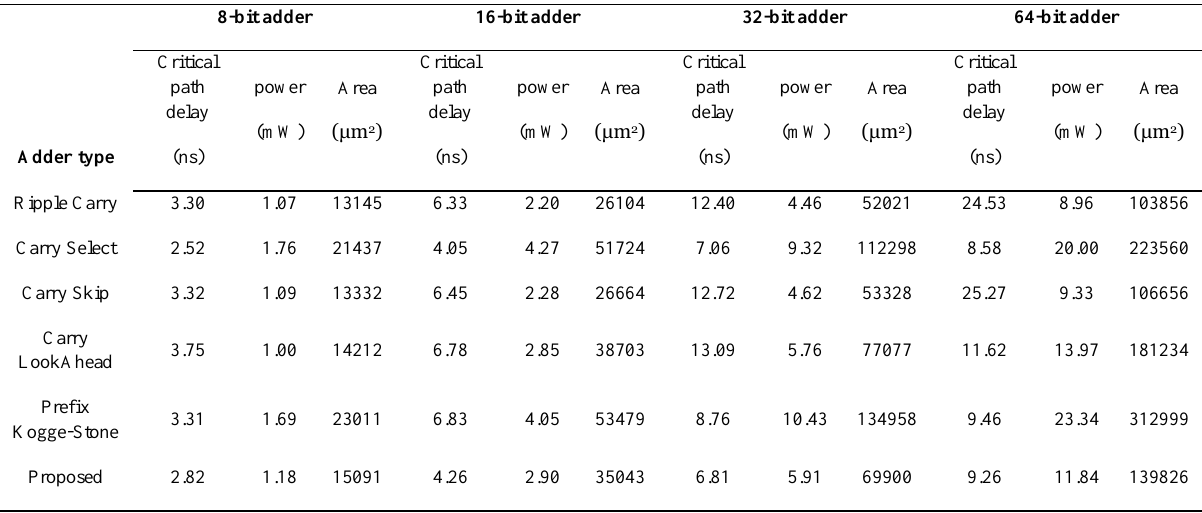
Table 3. Comparison of the proposed fast adder with other fast adders in terms of delay, area, and power consumption in a fast speed with t =0 °C and V supply = 1.98